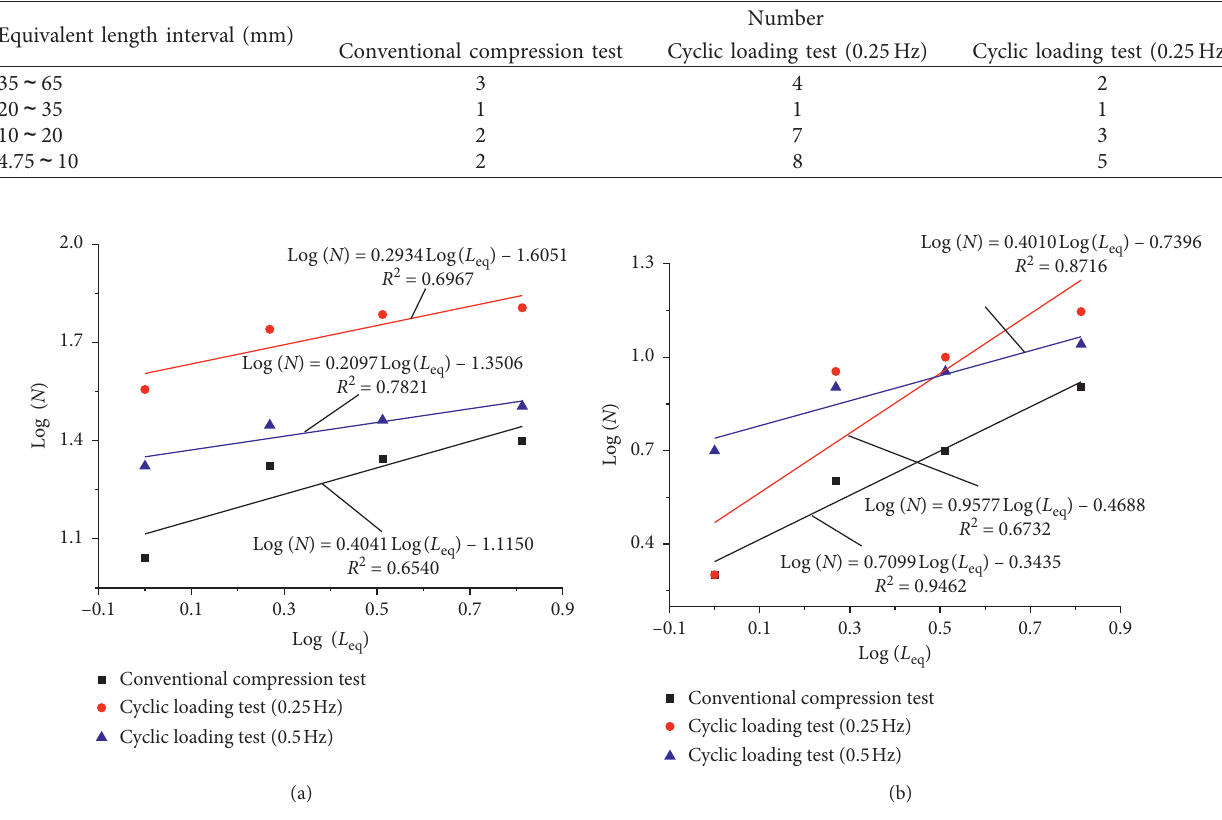
Figure 17: Logarithmic plot of limestone fragment equivalent length-quantity. (a) Uniaxial stress state. (b) Confining pressure of 10MPa. Table 8: Equivalent length interval and mass of limestone fragments under the uniaxial stress